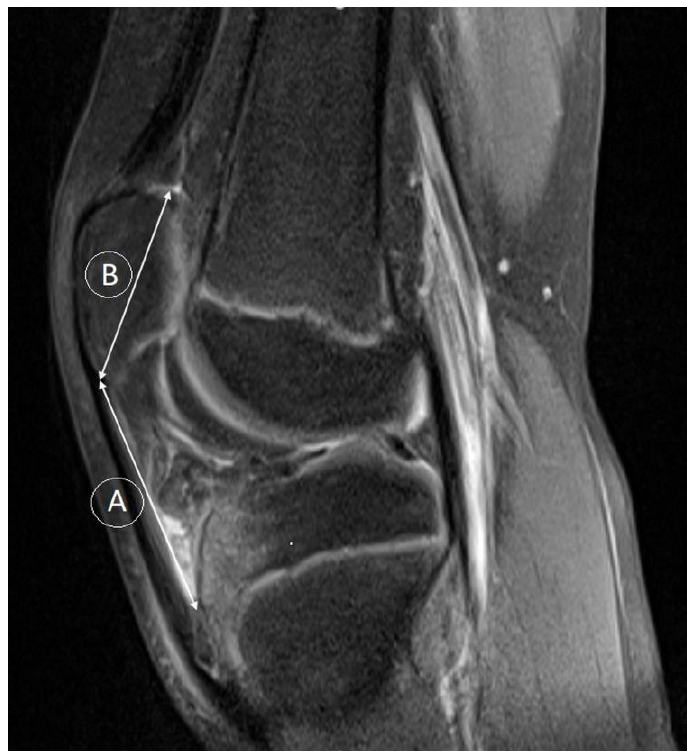
Figure 3. Patellar Insall–Salvati index (A:B). A—patellar tendon length, B—patellar length (described in the section Materials and Methods).